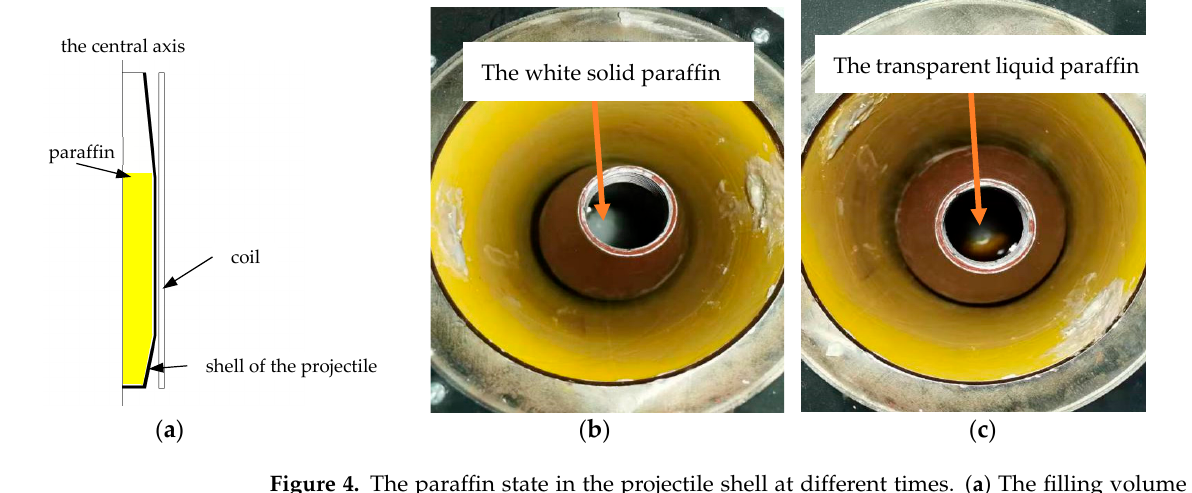
Figure 4. The paraffin state in the projectile shell at different times. ( a ) The filling volume of the paraffin. ( b ) The solid paraffin. ( c ) The melted paraffin. Table 6. The melting time under different excitation